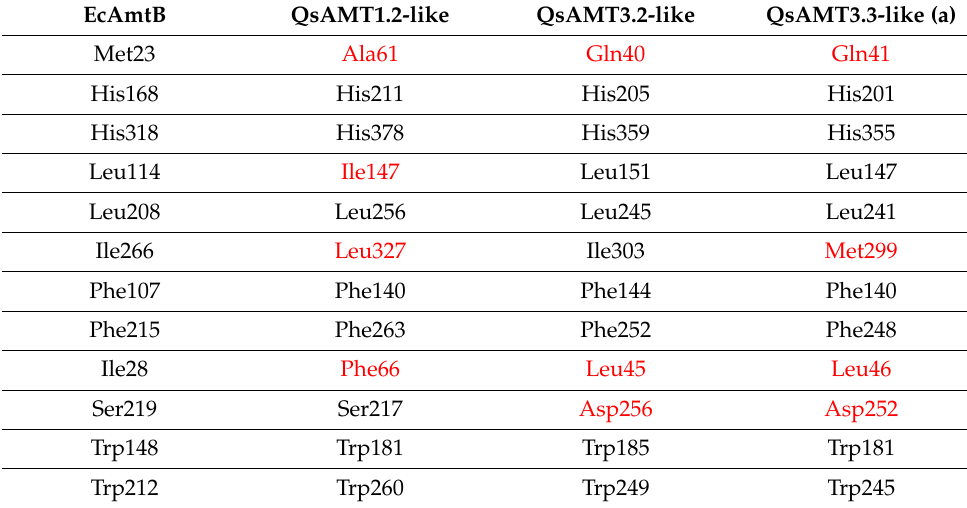
Table 1. Amino acid residues forming the channel of the EcAmtB (template) and the mycorrhiza- induced QsAMT1.2-like, QsAMT3.2-like, and QsAMT3.3-like (a). Different residues with respect to the ones in EcAmtB are highlighted in red. EcAmtB QsAMT1.2-like QsAMT3.2-like QsAMT3.3-like (a) Met23 Ala61 Gln40